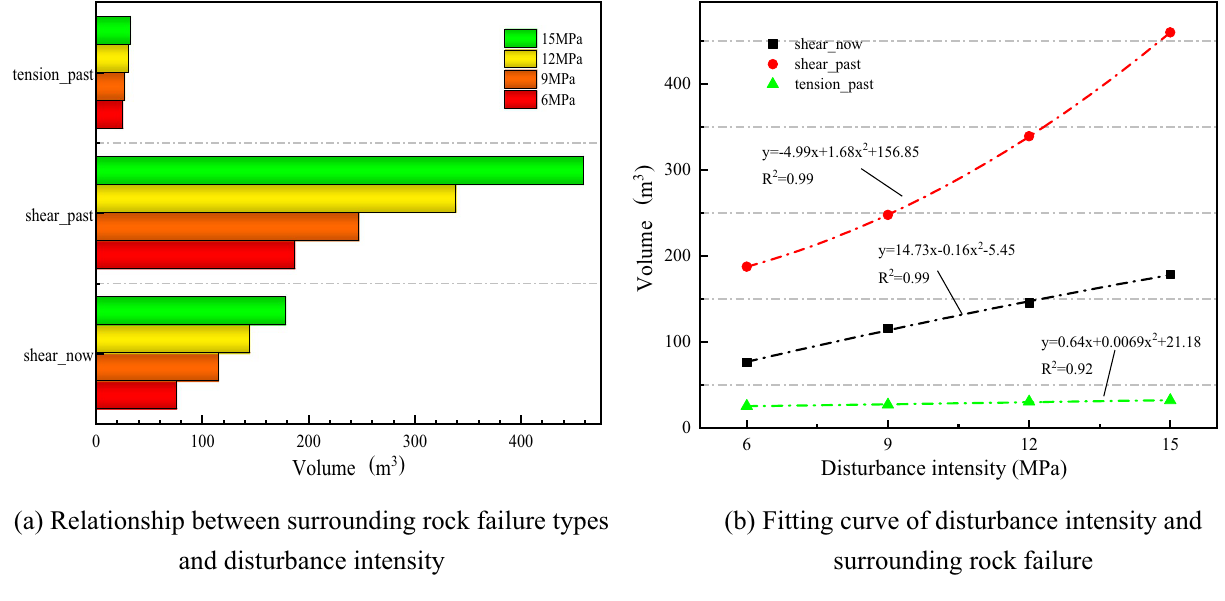
Figure 6. Variation law of surrounding rock failure types under different disturbance intensities.